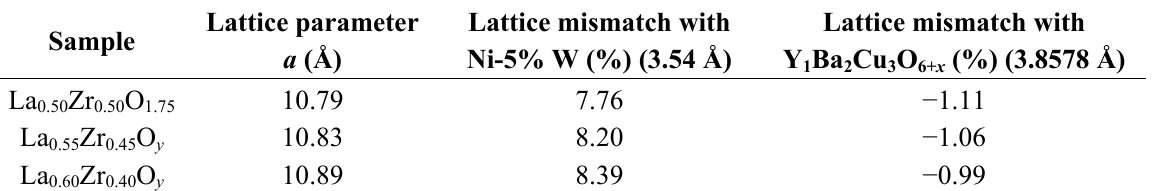
Table 2. Lattice parameters of the La with the Ni-5% W substrate and that of YBCO.